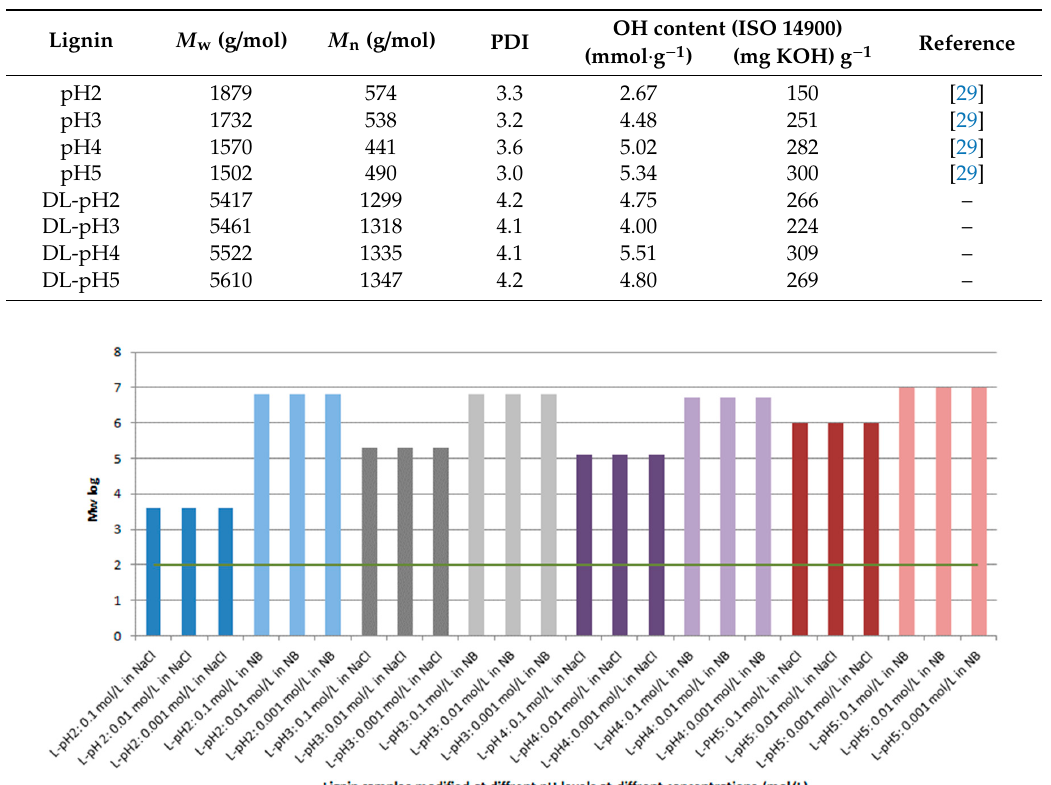
Table 2. Weight-average ( M w ) and number-average ( M n ) molecular weight and polydispersity (PDI) obtained by gel permeation chromatography (GPC) measurements, and OH content according to ISO 14900 for demethylated lignins (DL) and Kraft lignins isolated at di ff erent pH values [29].